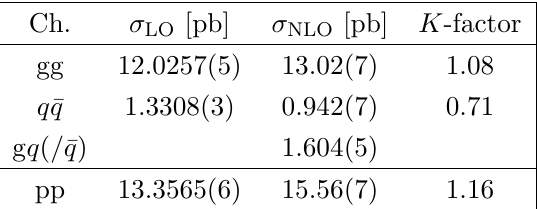
(cid:22) (cid:0) (cid:22) (cid:23) (cid:22) b(cid:22)bjj with its cor- !